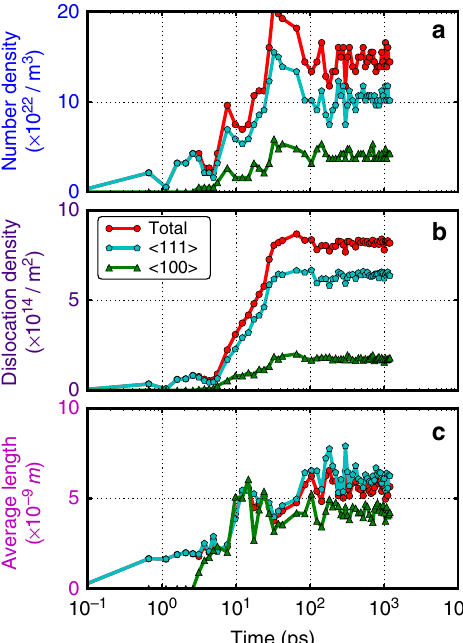
Fig. 3 Dislocation density. a The number density; b Density; c Average length of the dislocations of <100> and <111> types and total as a function of time